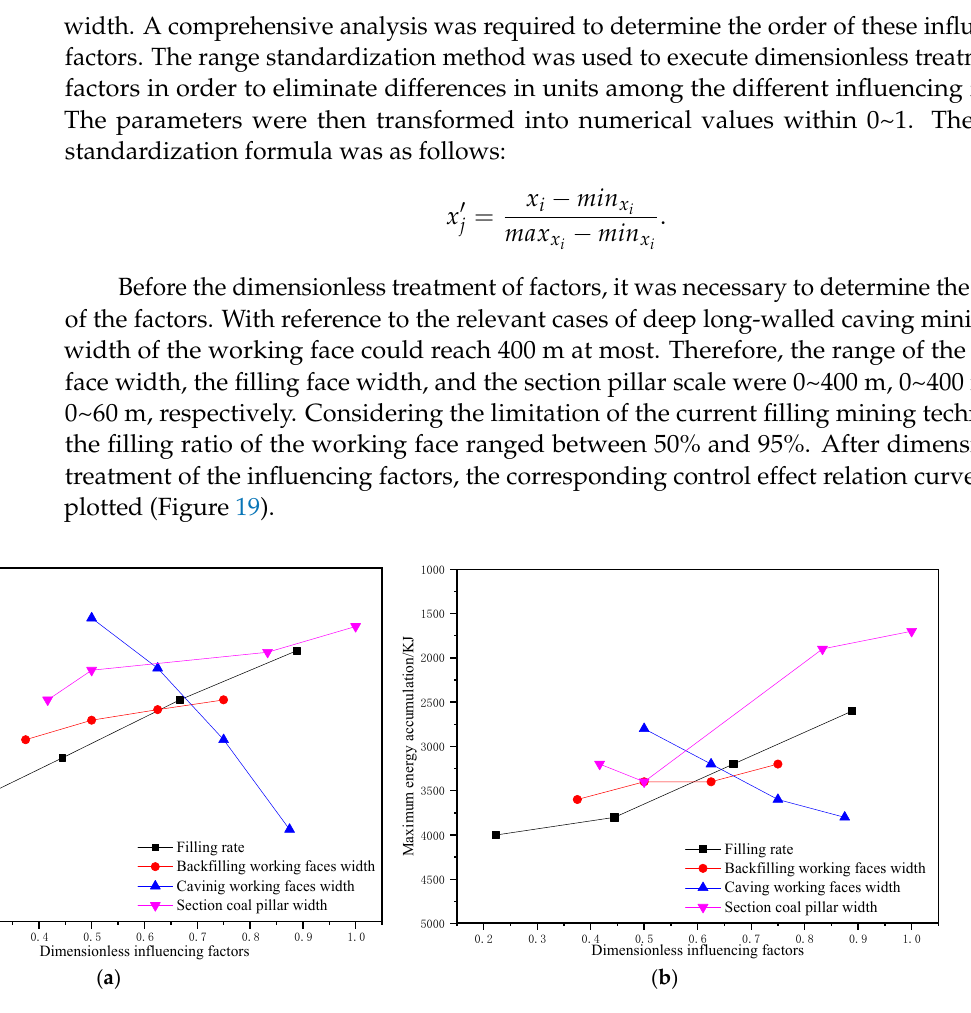
Table 13. Scheme designs of different mining modes.